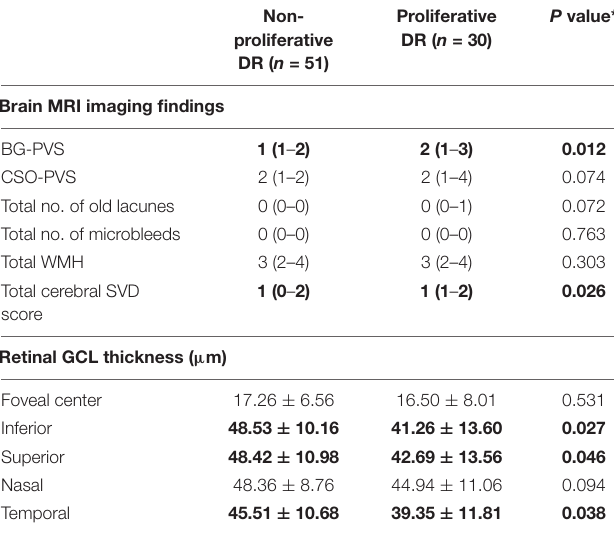
TABLE 2 | Cerebral and ophthalmic imaging findings according to the DR